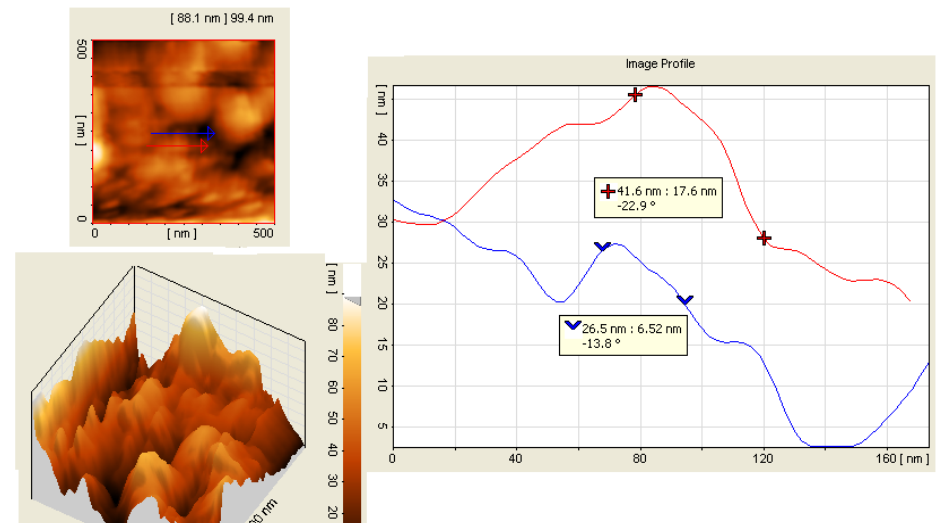
Figure 4 . AFM image of porous Si after Pt deposition and second stage of etching. The top left figure is two dimensional image in an area of 500 nm by 500 nm and the bottom left figure is its 3D surface image, where its analysis is shown in the right figure along the